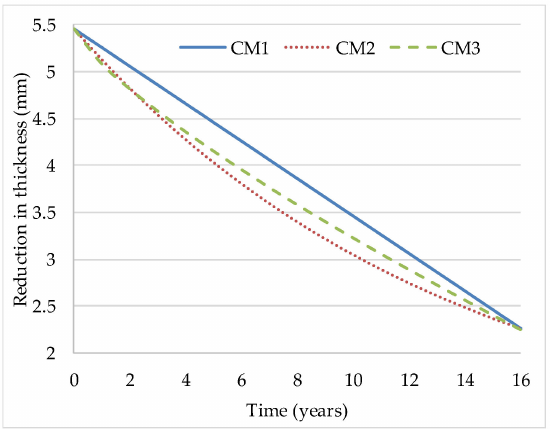
Figure 7. Corrosion-induced reduction in thickness provided by the three models as a function of time (years).